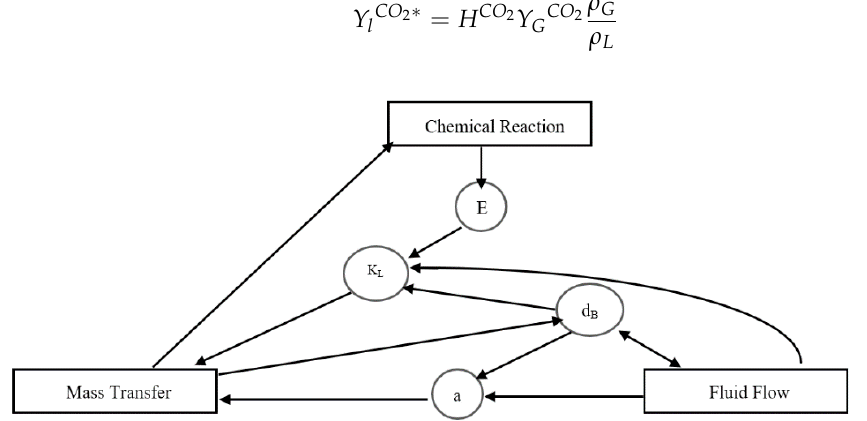
Figure 2. Schematic representation of inter-dependency of fluid flow, mass transfer, and chemical reaction.